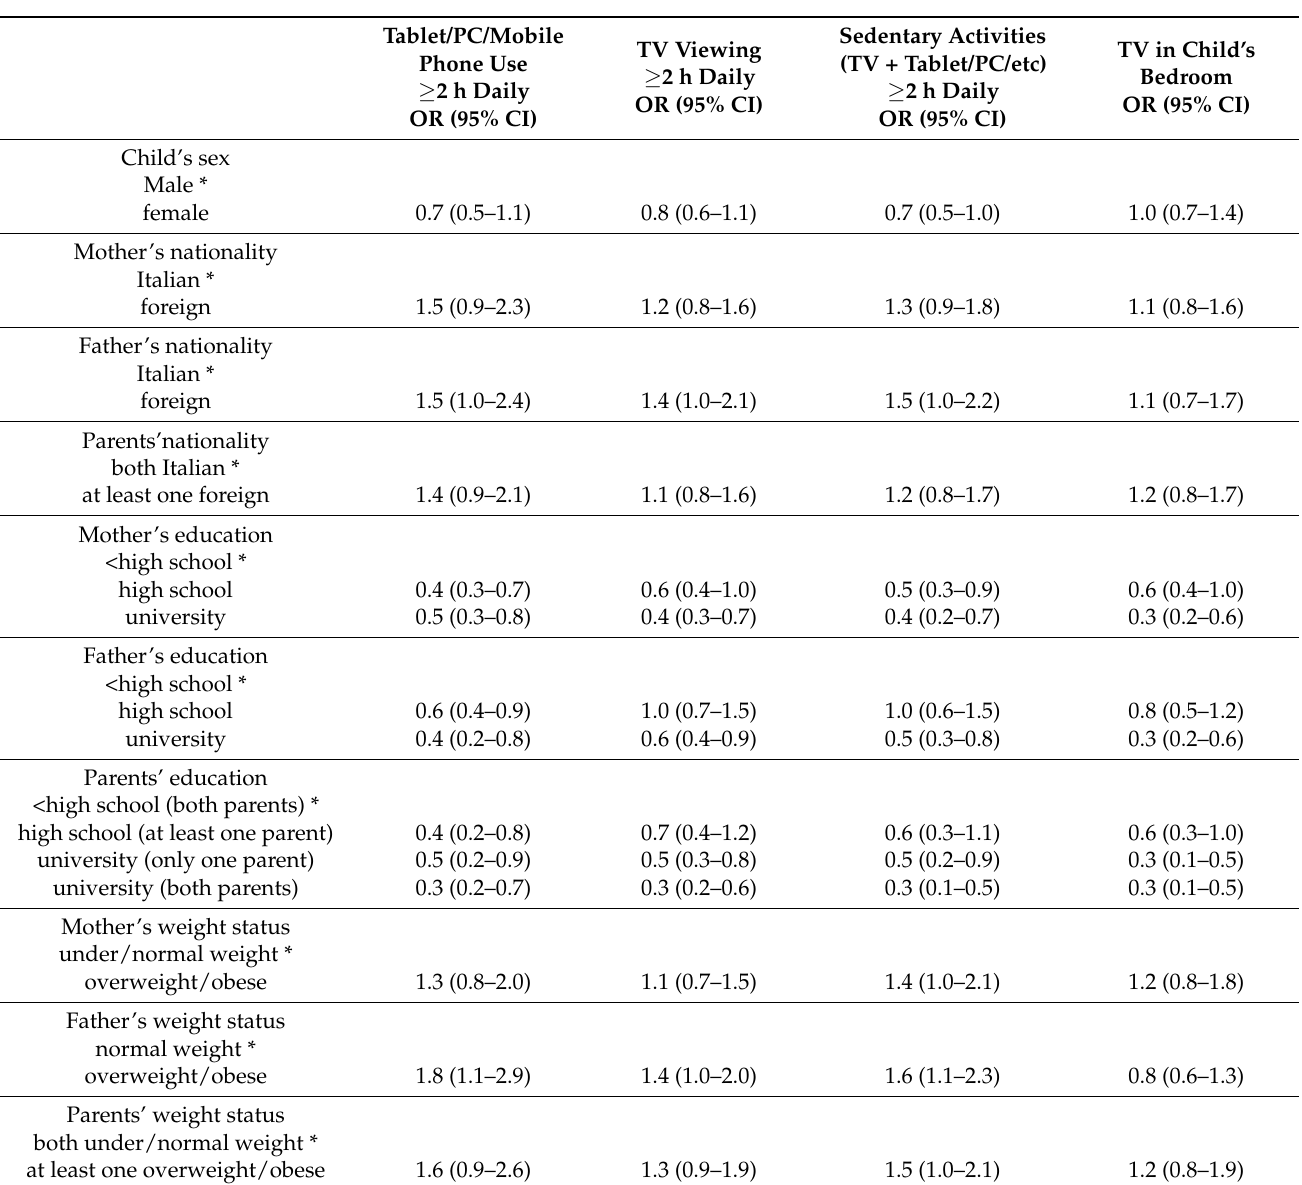
Table 3. Univariate logistic regression for outcomes of sedentary